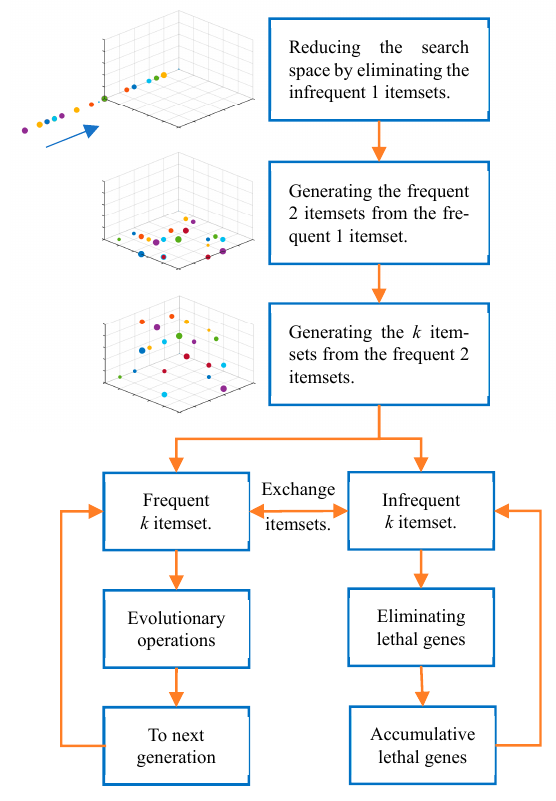
Figure 1. Flow chart of MOO.